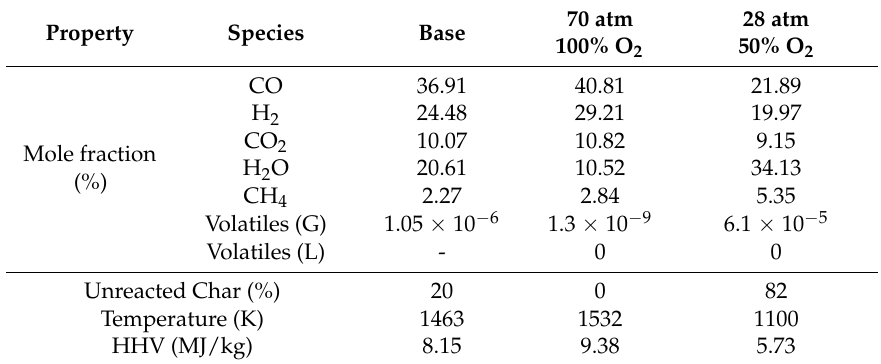
Table 10. Effect of operating pressure and oxygen amount on syngas composition and exit temperature.